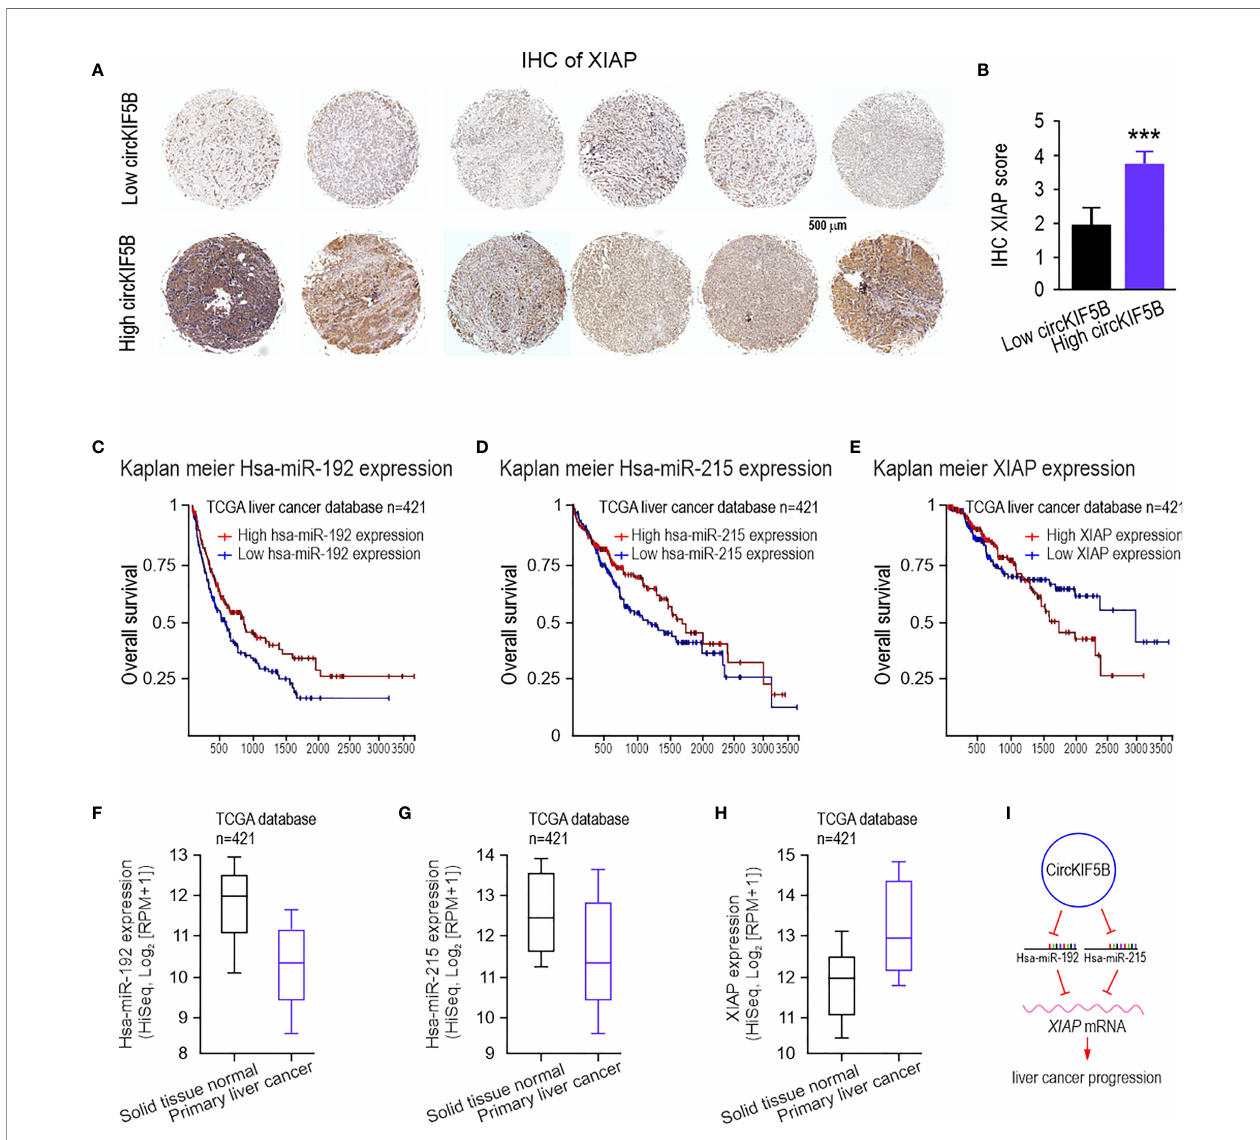
FIGURE 8 | The clinical signi fi cance of circKIF5B, miR-192s, and XIAP in human liver cancer patients. (A) IHC staining for liver cancer tissue microarrays (TMAs) with liver cancer and adjacent normal liver tissues using the XIAP antibodies. (B) IHC XIAP staining score analysis for TMAs. (C – E) The overall survival curves of patients with liver cancer strati fi ed by miR-192s and XIAP levels in their primary tumors. (F – H) RNA-seq data for expression of the miR-192 family (F, G) and XIAP (H) , in solid tissue normal (n = 50) and primary tumor (n = 371) in the TCGA database. (I) Function and mechanism of circKIF5B during liver cancer progression. ***P <